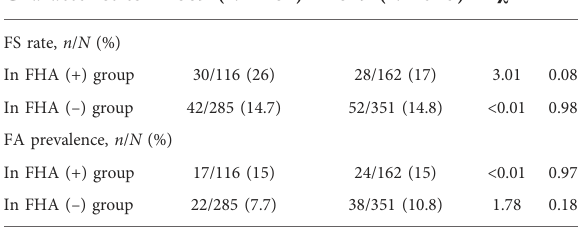
TABLE 2 The FS † rate and FA ‡ prevalence in different participants in 2009 and 2019. Characteristics 2009 ( N = 401) 2019 ( N = 513)